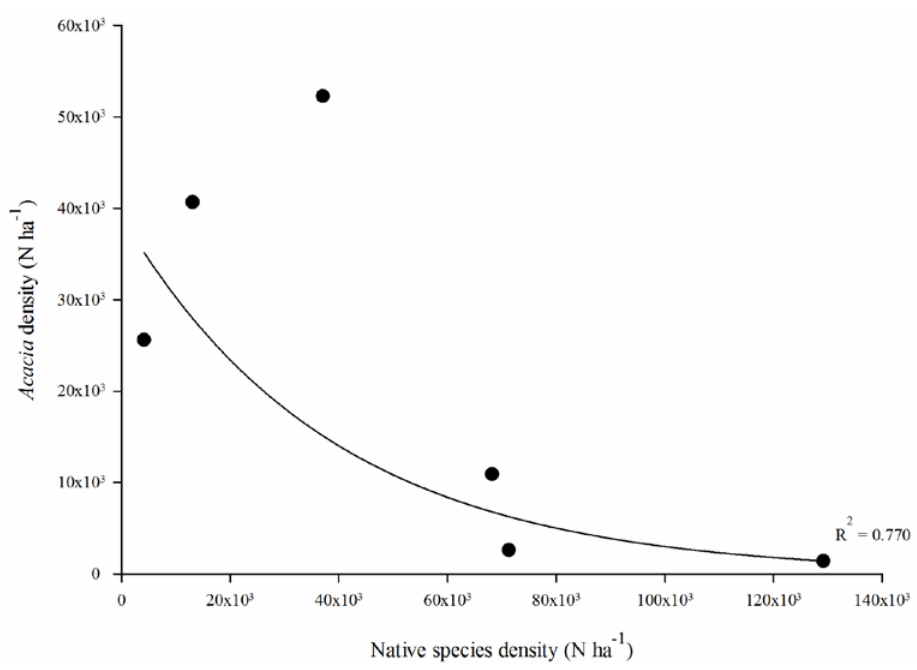
Figure 3. Relationship between the density of the native woody species and Acacia saligna regeneration. Table 2. Distribution in height class (%) of the woody species regeneration. The relative contribution (%) of each species to each height class is reported within round brackets. Means are followed by the standard error.